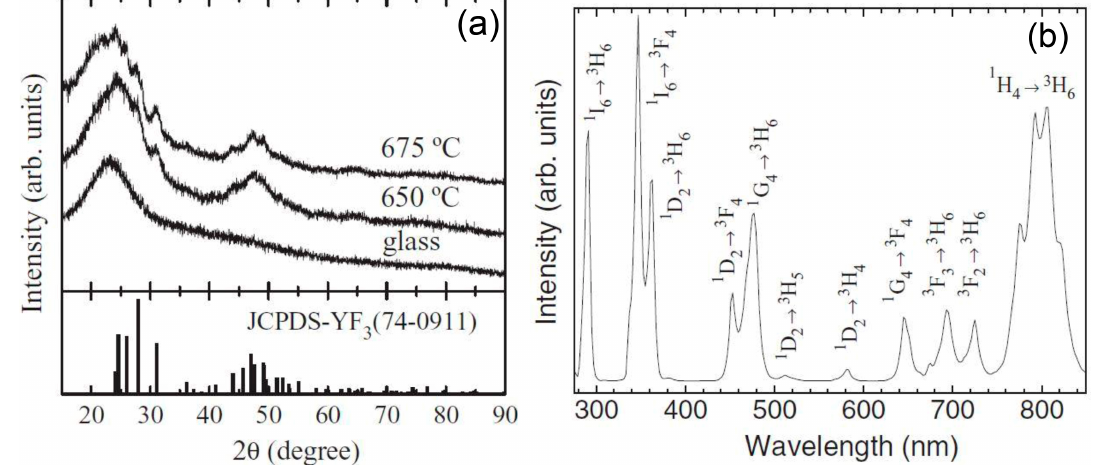
Figure 4. ( a ) XRD patterns of 90SiO 2 -10YF 3 Ln 3+ -doped GCs heat treated at 650 and 675 °C together with the JCPDS-YF 3 and ( b ) Up-conversion emission spectrum of GCs co-doped with 1.5 Yb 3+ and 0.1 Tm 3+ heat-treated at 675 °C [60].